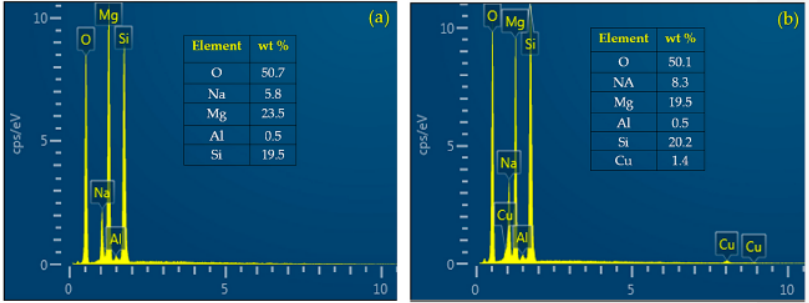
Figure 3. EDS point analysis of ( a ) MAO/AZ31 and ( b ) Cu/MAO/AZ31.